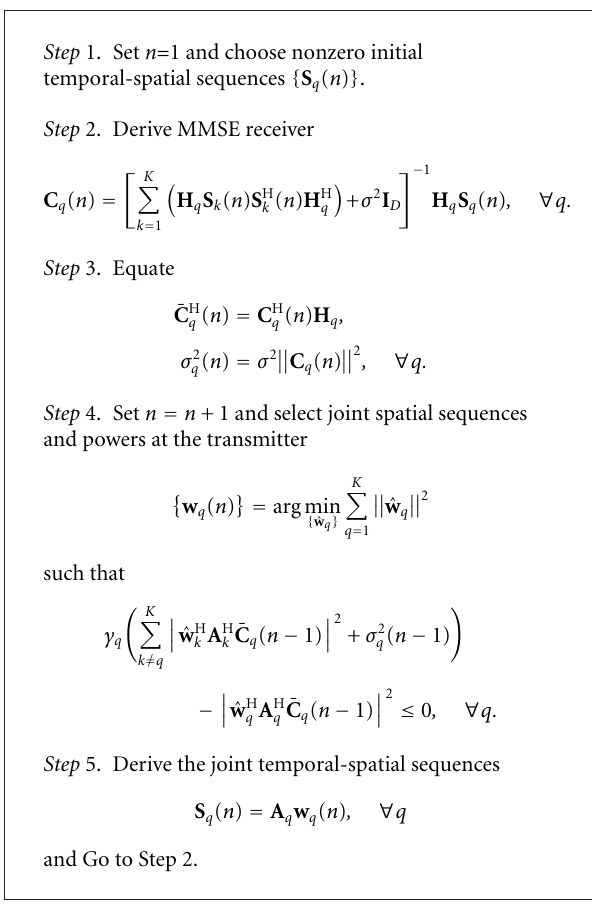
Scheme 1: Optimization algorithm with fixed spreading